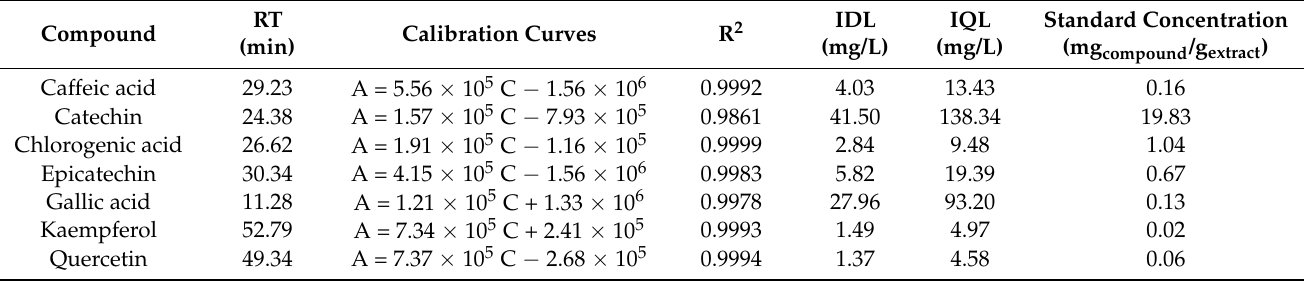
Table 3. Main phenolic compounds of M. oleifera extract quantified by